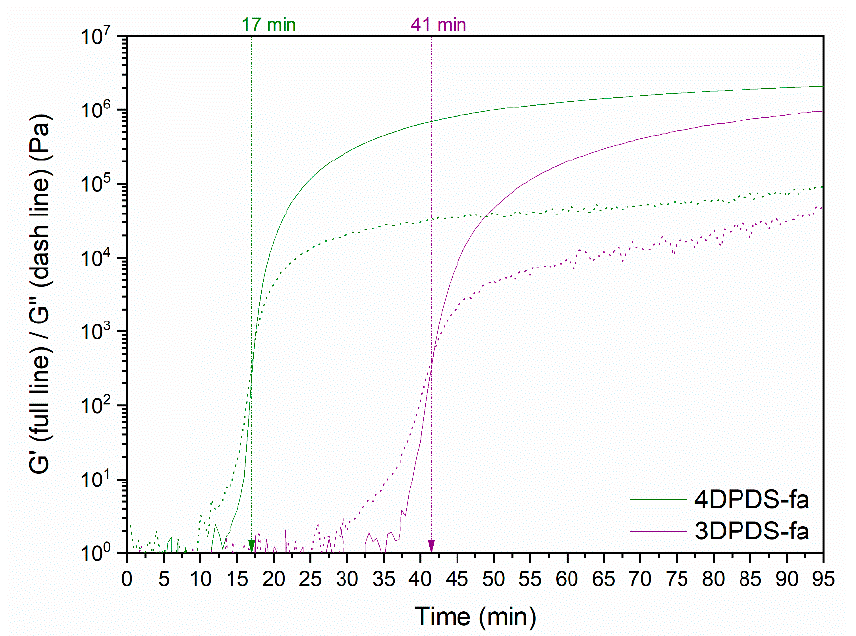
Figure A11. Curing behavior of 4DPDS-fa, and 3DPDS-fa by rheo-kinetics measurement at 150 °C over time. Full line storage modulus (G’) and dash line (G”). Gelation points are indicated by dotted lines with arrows.